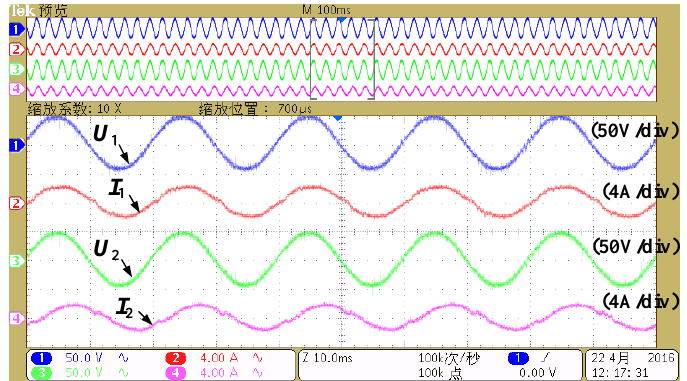
Figure 19. Steady state experimental waveforms of Case II.